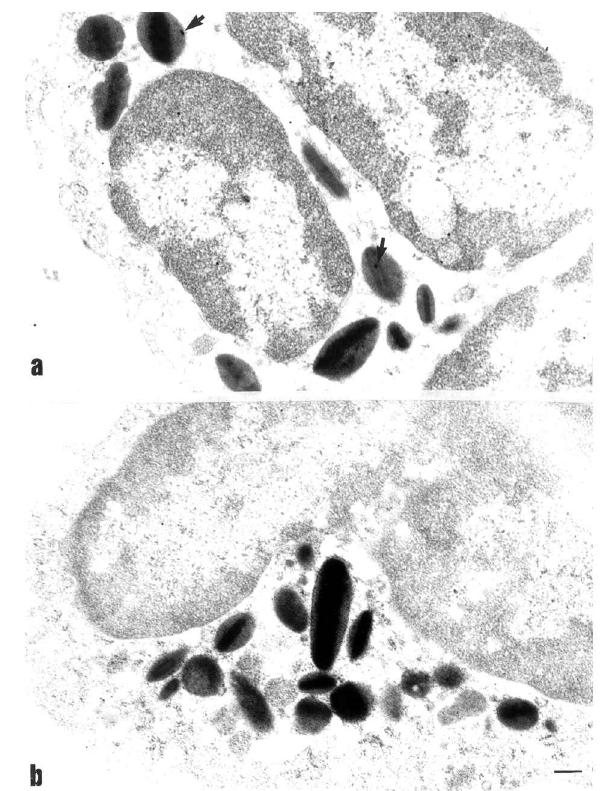
FIG. 4. Intact ANXA1 in rat mesenteric eosinophils: LCPS1 immunocytochemistry. Untreated rats were used for this staining. (A) Eosinophil view showing gold particles asso- ciated in the nucleus and specific granules (arrows). (B) Control section incubated with non-immune sheep serum. No gold labeling was observed. Bars: 0.2 m